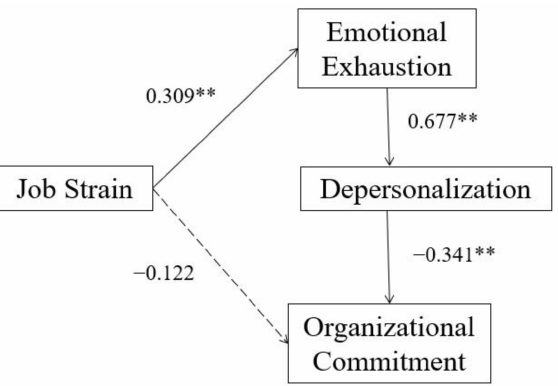
Figure 2. Final model ( n = 509, R 2 = 0.348). ** p < 0.01 (2-tails).